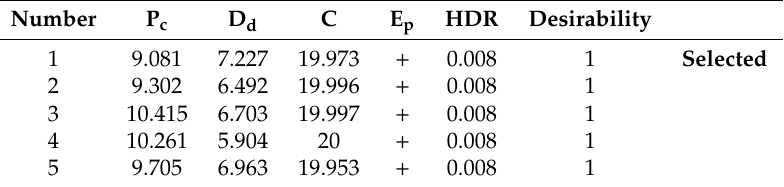
Table 7. Solutions for maximizing HDR suggested by the software.